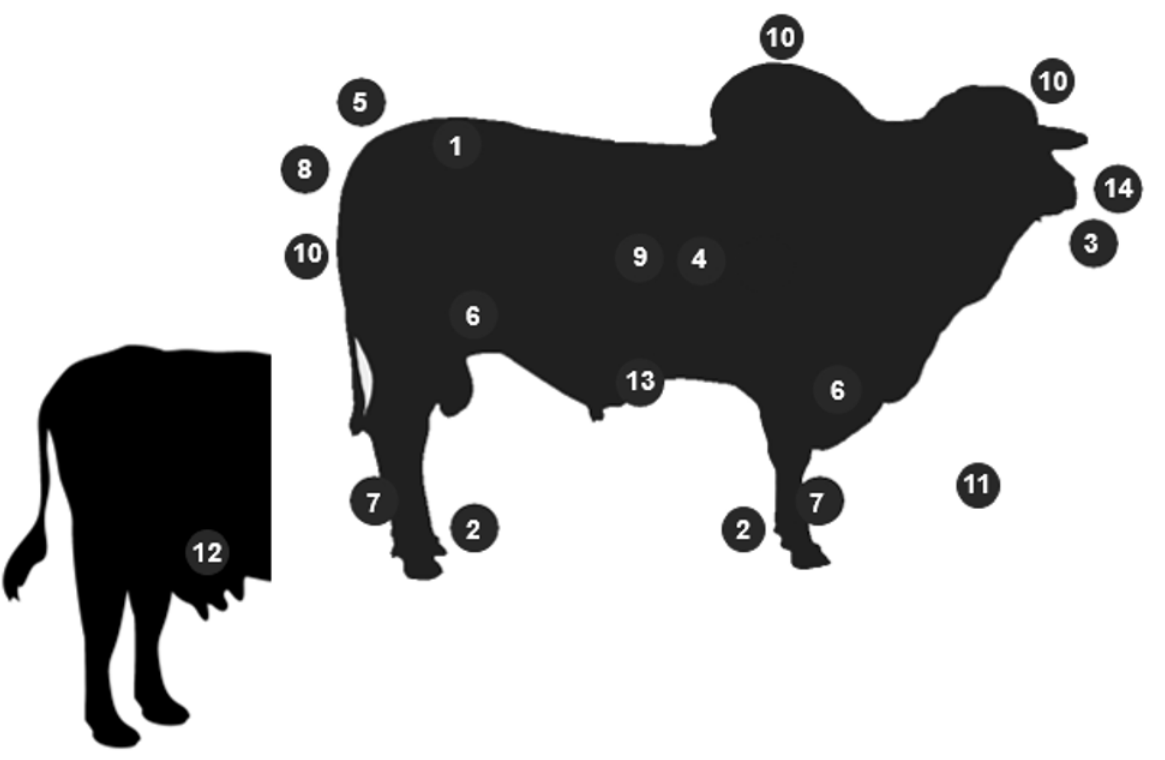
Figure 1. Visual scores evaluation of Nellore Qualitas Program. 1 = rump angle; 2 = structure foundation; 3 = mouth; 4 = frame; 5 = tail insertion; 6 = muscularity; 7 = Bones; 8 = Fur/pigmentation; 9 = depth; 10 = reproduction; 11 = temperament; 12 = udder; 13 = navel; 14 = racial. Adapted from: Nellore Qualitas (Qualitas